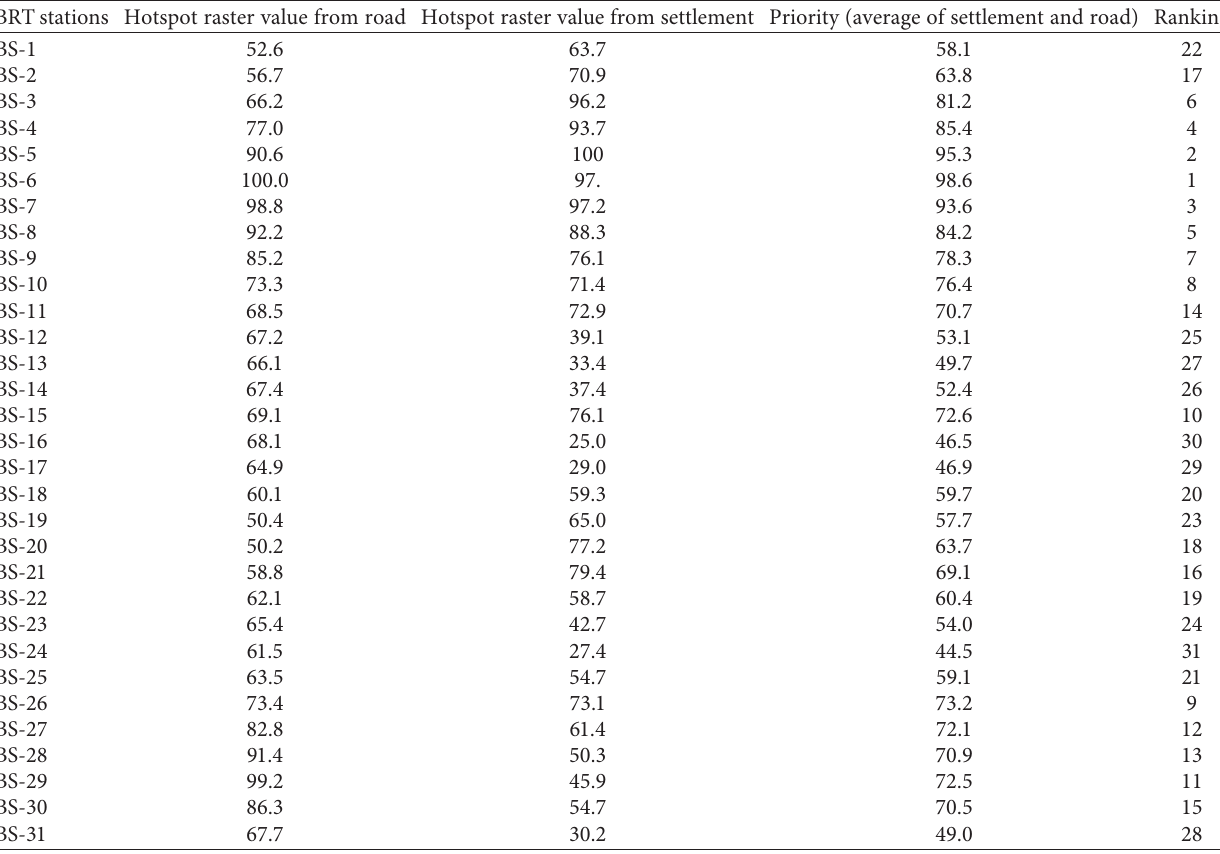
Table 3: BRT stations ranking system.